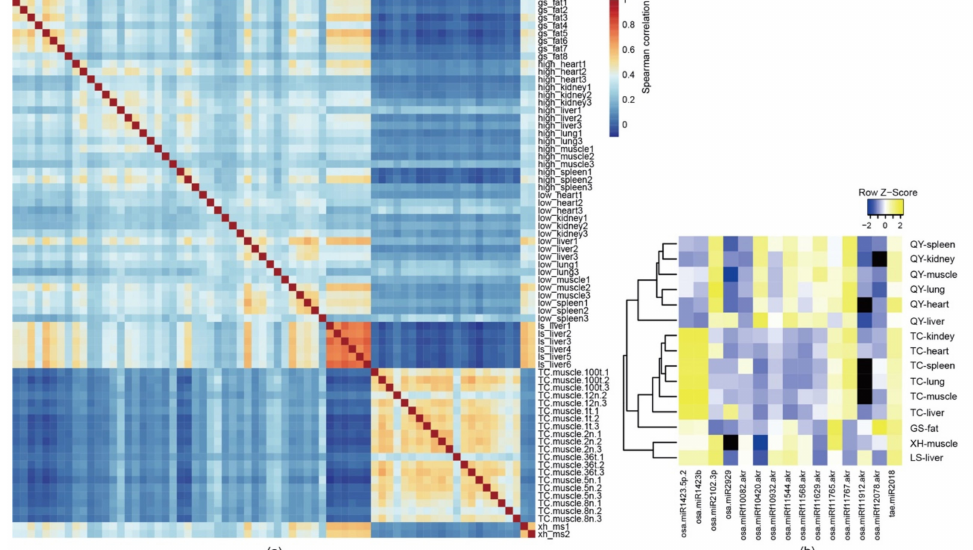
Figure 1. Expression scheme of plant miRNAs in different chicken breeds and tissues. ( a ) Spearman’s correlation heatmap of the plant miRNA expression among different chicken breeds and tissues. ( b ) Mean expression levels (reads counts) of 15 plant miRNAs were detected in 7 tissues or organs from 5 Chinese native free-range chicken breeds. Note: O. sativa (rice, osa), T. aestivum (wheat,